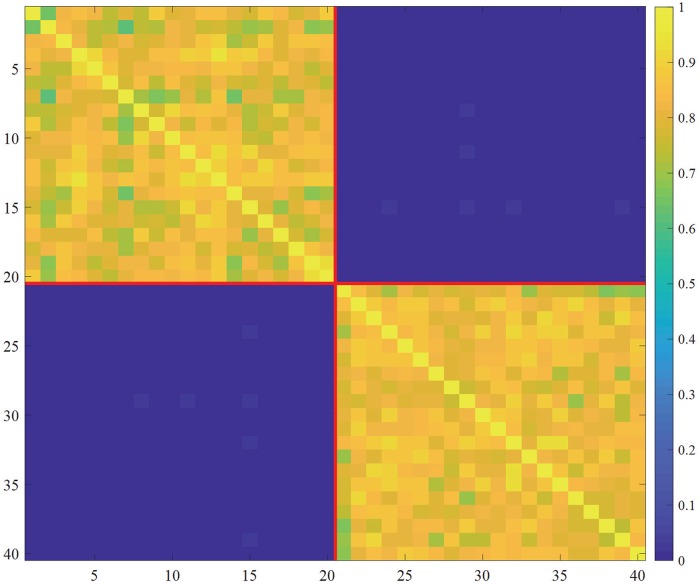
A correlation matrix which reflects two subsets of variables {1, 2, …, 20} and {21, 22, …, 40}.